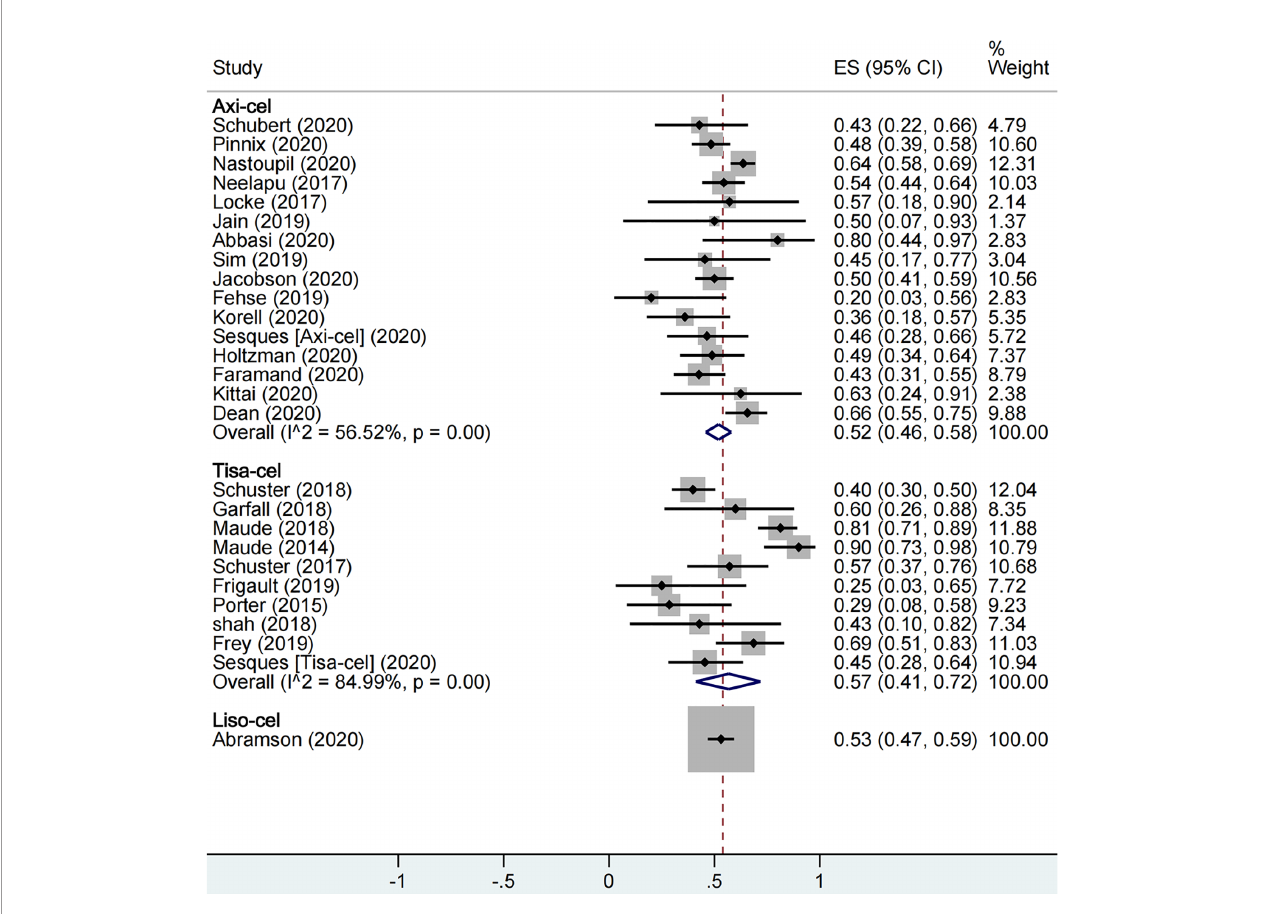
FIGURE 3 | The forest plot of total complete response rate of each